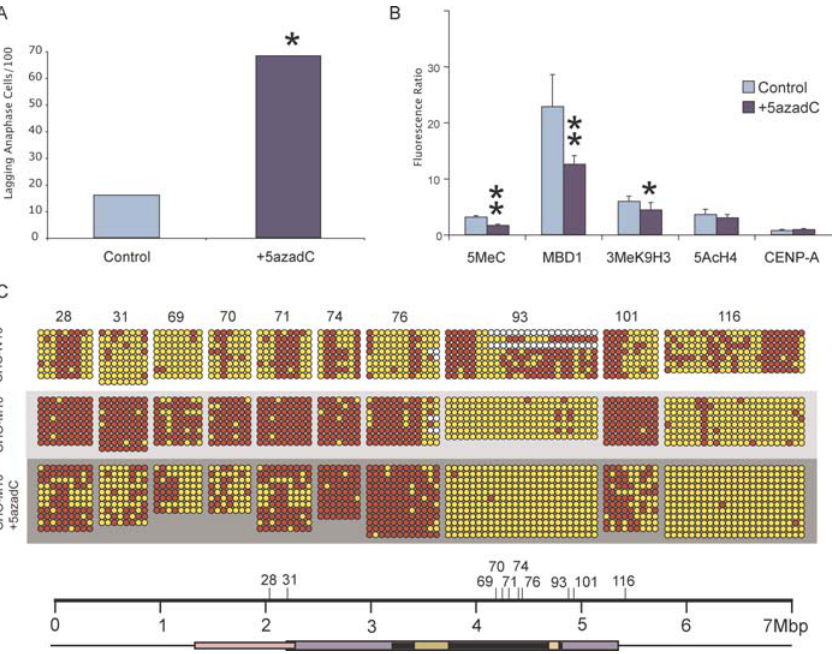
Figure 7. Effects of 20 l M 5-aza-dC Treatment on the 10q25 Neocentromere